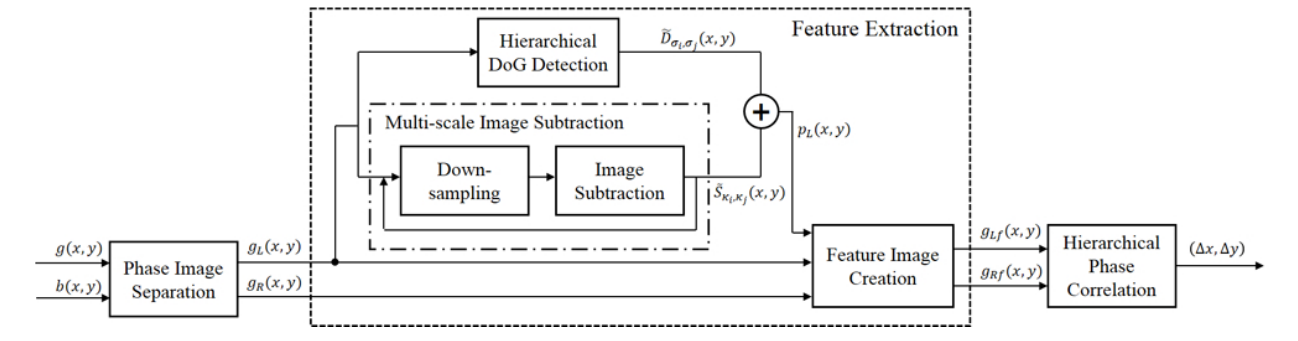
Figure 4. The framework of the proposed system.